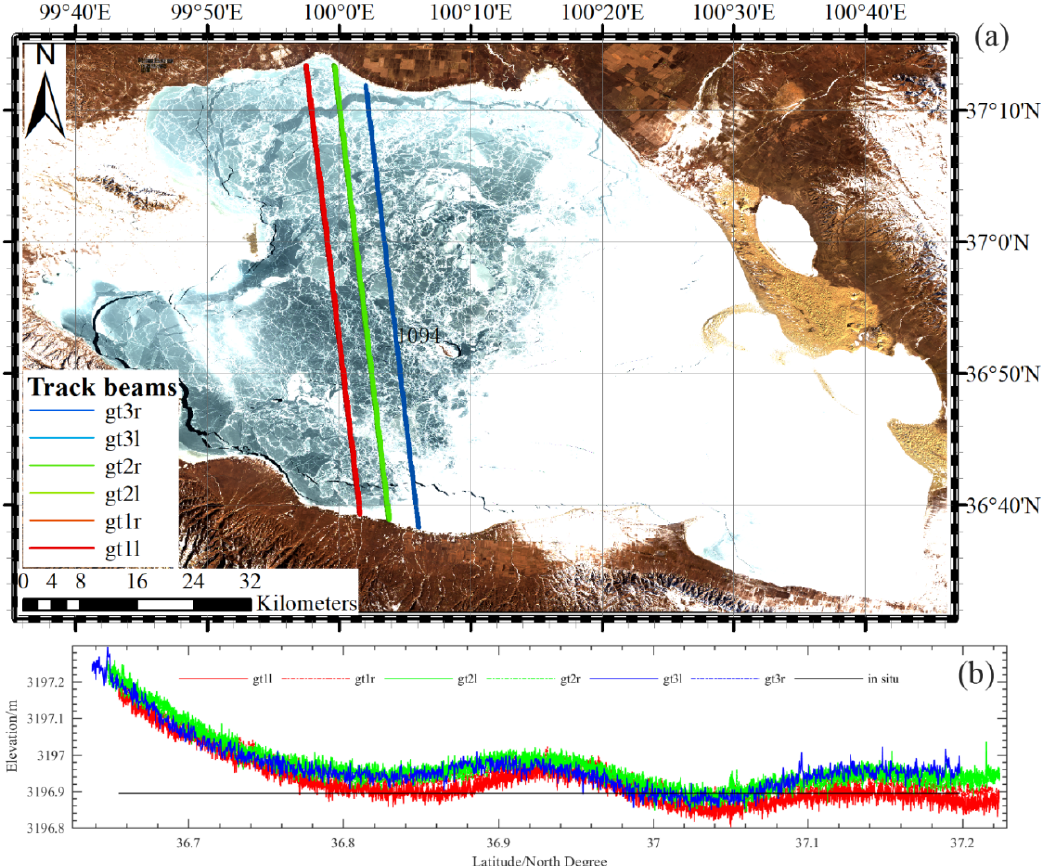
Figure 12. The 1094 Track ID on 10 March 2019 for Qinghai Lake (Landsat 8 OLI 11 January 2019) and the surface water height in gt1l, gt1r, gt2l, gt2r, gt3l, and gt3r on 3 October 2019 ( a ) showed the six sub-ground tracks; ( b ) showed the water 521 level along the six sub-ground tracks).